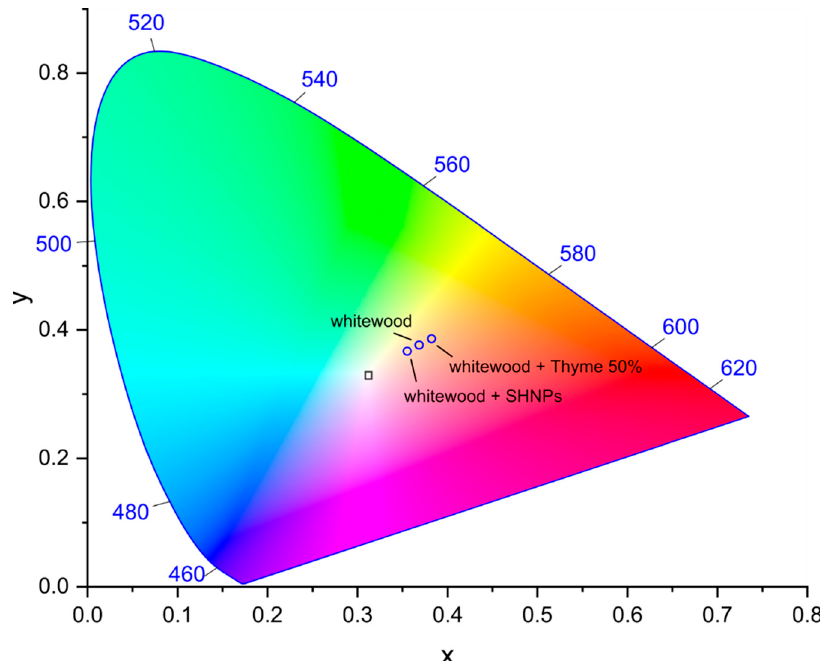
Figure 3. The CIE 1931 color space diagram with the calculated colors for selected whitewood samples (blue circle symbols). The black square symbol shows the ideally reflecting surface.